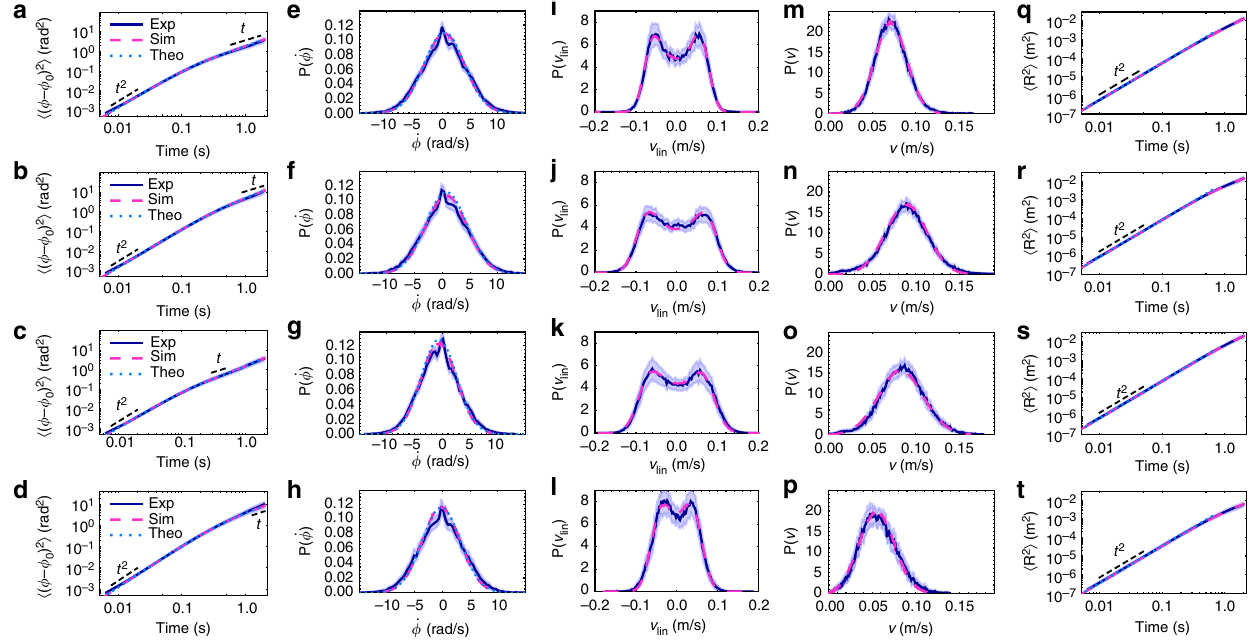
Fig. 3 Determination of model parameters for the generic, carrier, tug and ring particles (ordered from top to bottom). a – d Rotational mean squared displacement, e – h rotational velocity distribution, i – l linear velocity distribution, m – p absolute velocity distribution, q – t translational mean squared displacement. Solid dark blue and dashed magenta curves show the experimental data and simulation results, respectively. Dotted light blue plots are the theoretical solutions. Experimental error intervals represent the standard error of the mean (3 s.e.m). The parameter values are listed in Supplementary